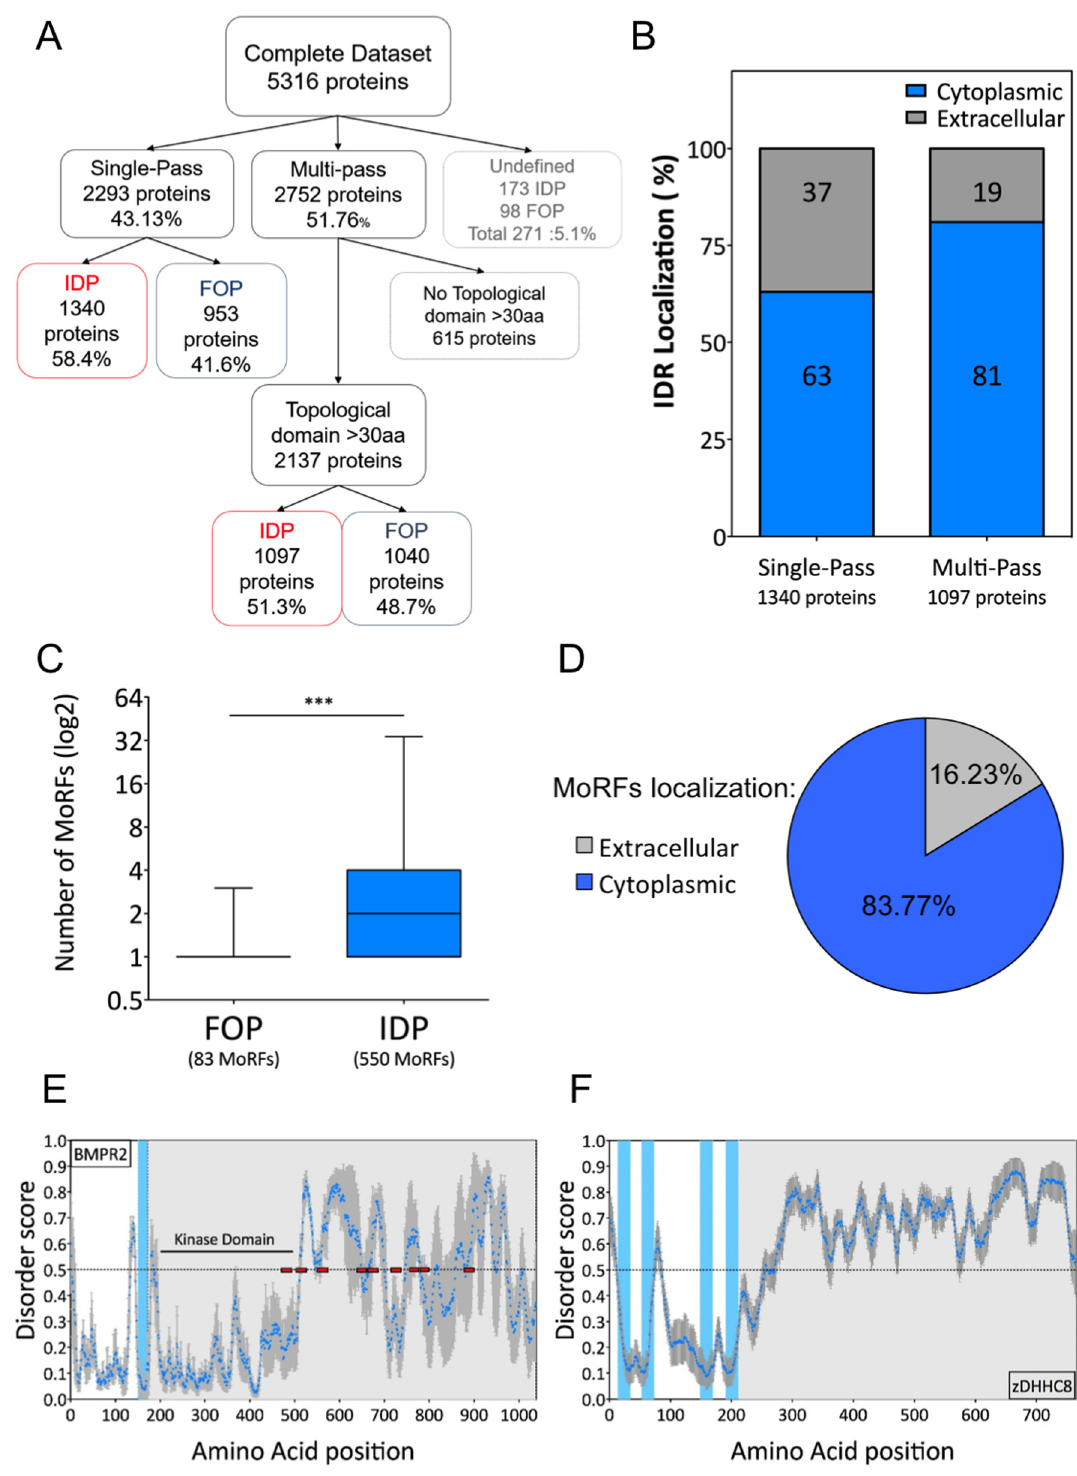
Fig 3. Intrinsic disorder according to transmembrane protein classes and topology. (A) Organization of the different protein dataset depending on the transmembrane protein classes and the presence or not of IDRs. B) Percent of IDRs localized in the cytoplasm or the extracellular domain of single-pass and multi-pass proteins. (C) Prediction of MoRFs in the proteins from the fully folded protein (FOP) and IDP datasets. Mann-Whitney Significance test *** : p value < 0.0001. (D) Percentage of MoRFs localized either on the cytoplasmic or extracellular part of transmembrane proteins. (E) BMPR2